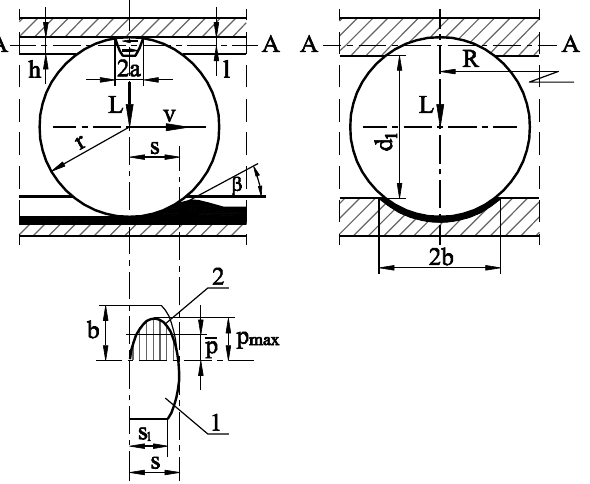
Figure A1. Simplified diagram of the contact area between the ball, the upper race and the coal layer, where 1 is the area of contact and 2 is the pressure distribution at the interface between the ball and the coal layer.